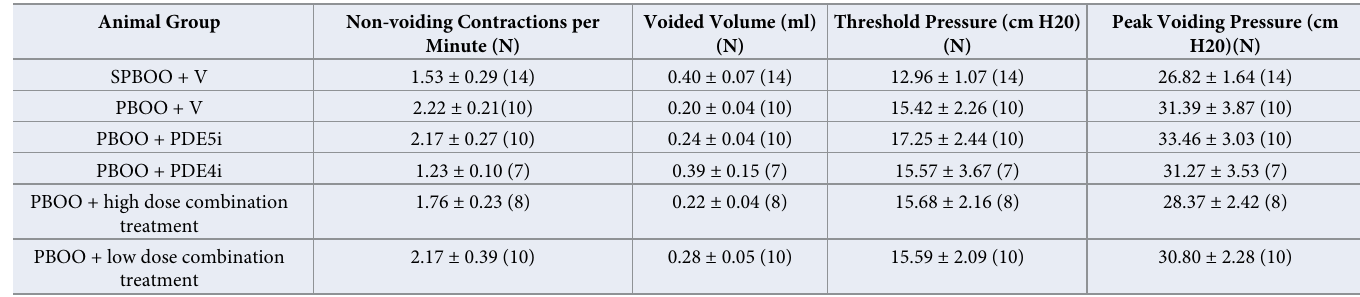
Table 1. Additional outcomes of conscious cystometry. Animal